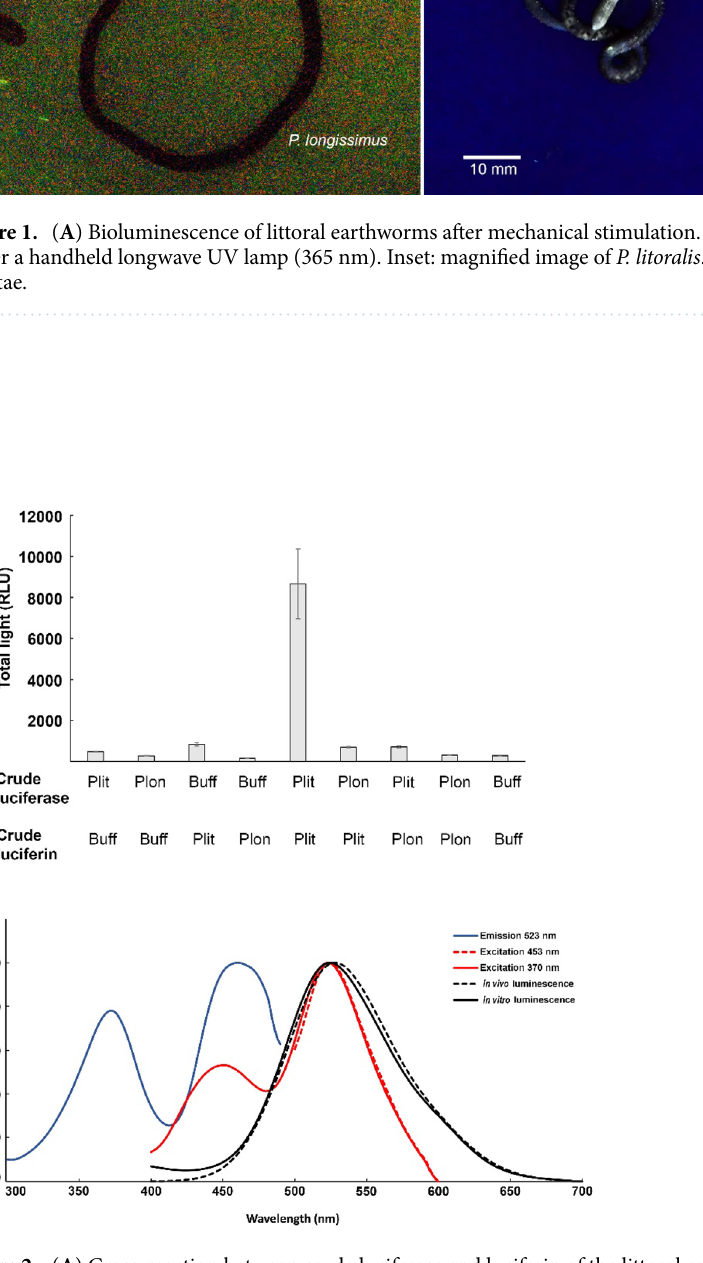
Figure 2. ( A ) Cross-reaction between crude luciferase and luciferin of the littoral earthworm genus Pontodrilus . Plit represents P. litoralis , Plon represents P. longissimus , and Buff represents the buffer (50 mM Tris–HCl, pH 7.2). Data are shown as the mean ± standard deviation ( n = 3). ( B ) Fluorescence spectra of crude coelomic fluid extracted from P. litoralis . An excitation spectrum (solid blue line) with emission at 523 nm, an emission spectrum (dashed red line) with excitation at 453 nm, and an emission spectrum (solid red line) with excitation at 370 nm were obtained. The dashed black line shows the in vivo luminescence spectrum of live P. litoralis . The solid black line shows the in vitro luminescence spectrum of crude coelomic fluid extracted from P. litoralis , which contained 500 µl 50 mM Tris–HCl at pH 7.2 and 50 µl 0.3% hydrogen peroxide. The data shown are the means of five